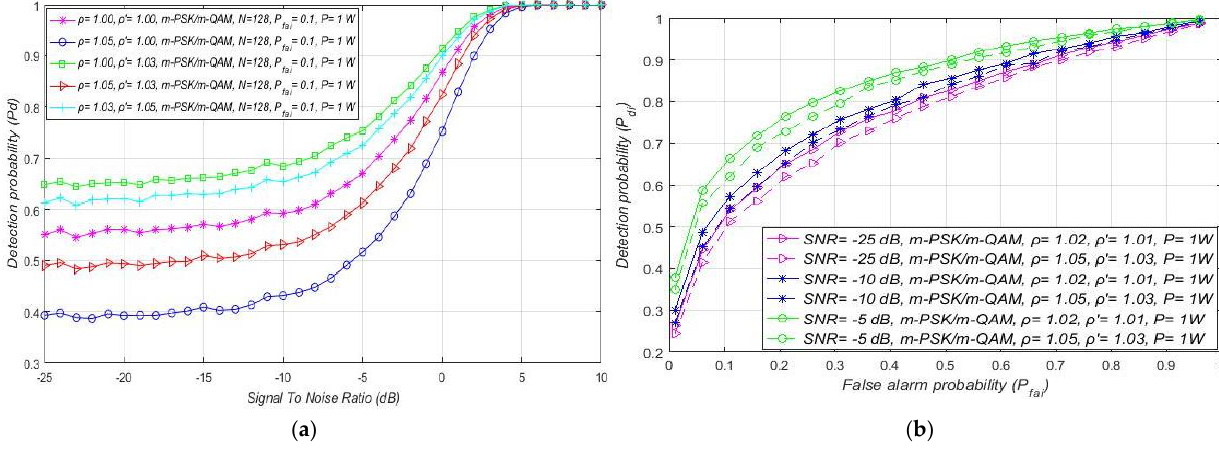
Figure 9. ( a ) Detection probability vs. SNR for signals transmitted in RA systems; ( b ) Interdependence between probabilities of detection and false alarm for versatile NUs, DTs and SNRs in the case of RA system.